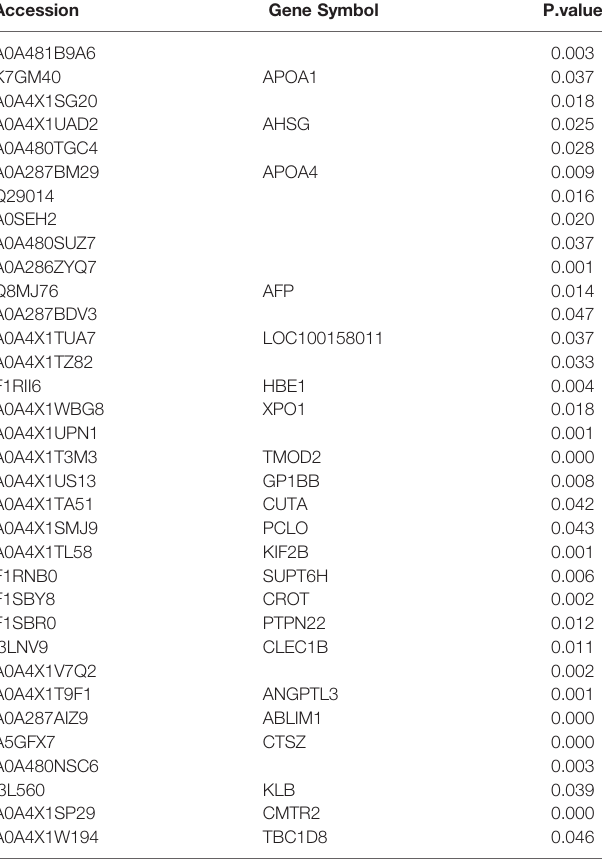
TABLE 1 | Signi fi cantly down-regulated proteins in ASFV-EVS. Accession Gene Symbol P.value